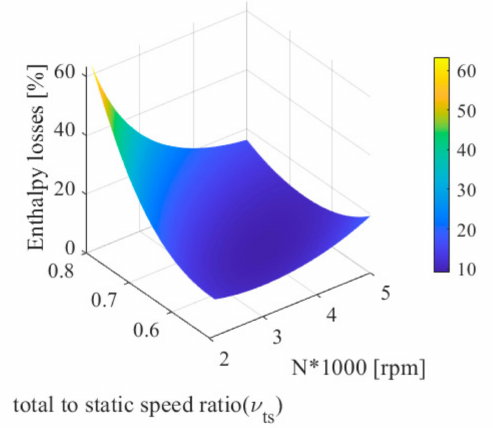
Figure 10. Variation of the enthalpy losses with the total to static speed ratio and rotor RPM.